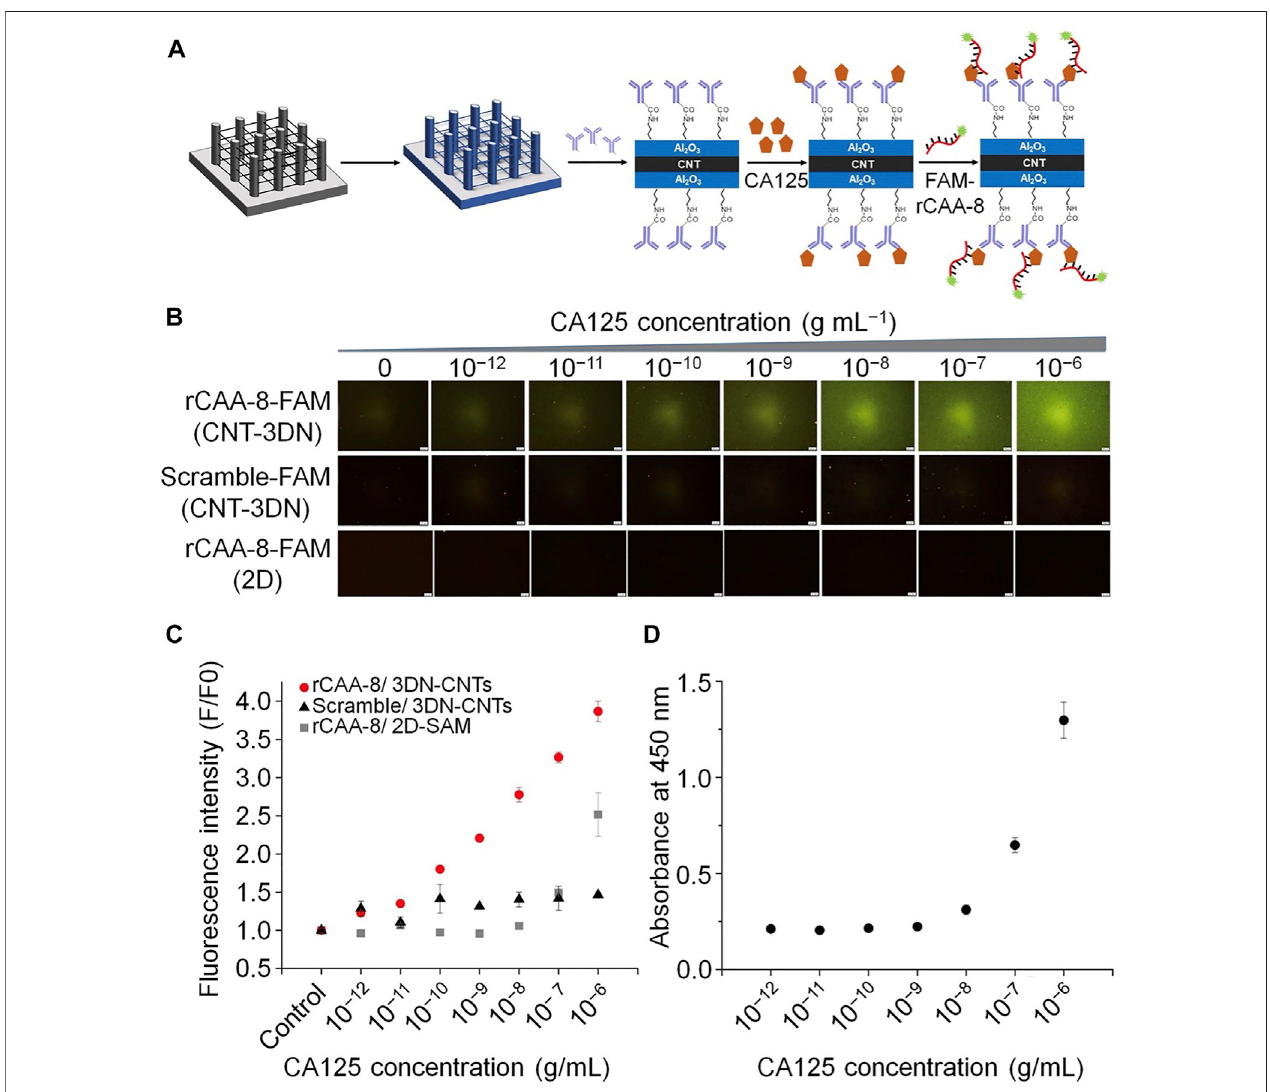
FIGURE 3 | Schematic illustration of the fl uorescent aptamers used to determine CA125 concentration. (A) The process of detecting CA125 using an antibody- aptamer on 3DN-CNT. (B) Microscopic fl uorescence images from rCAA-8-FAM/3DN-CNTs. (C) Fluorescence intensity corresponding to the concentration of CA125 detected by different platforms. (D) Standard curve from conventional ELISA to determine CA125 concentration.